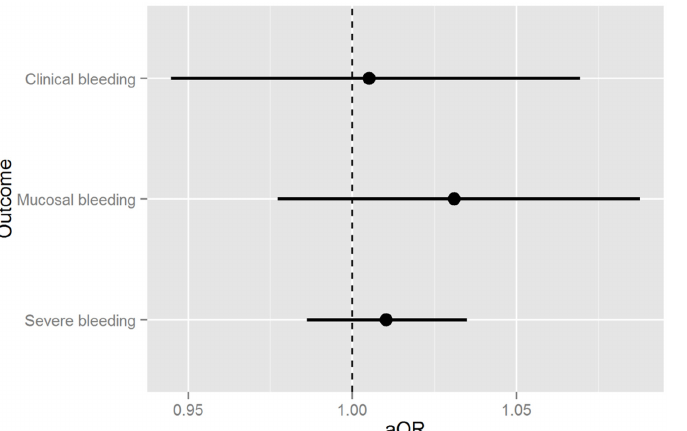
Fig 2. Treatment effects after propensity score matching showing that platelet transfusion had no effect on bleeding after adjustment for variables * that may have influenced physician's decision to transfuse platelets. * Variables: age, year of infection, dengue hemorrhagic fever, severe dengue, diabetes mellitus, cardiac disease, fever day at presentation, presence of any warning signs, temperature, leukocyte count, neutrophil percentage, platelet count, gender, systolic blood pressure < 90mmHg and whether AST, PT and PTT were taken. Clinical bleeding: OR 1.01 (Confidence limit 0.94 – 1.07); mucosal bleeding: OR 1.03 (Confidence limit 0.98 – 1.09); internal bleeding: OR 1.01 (Confidence limit 0.97 – 1.03)